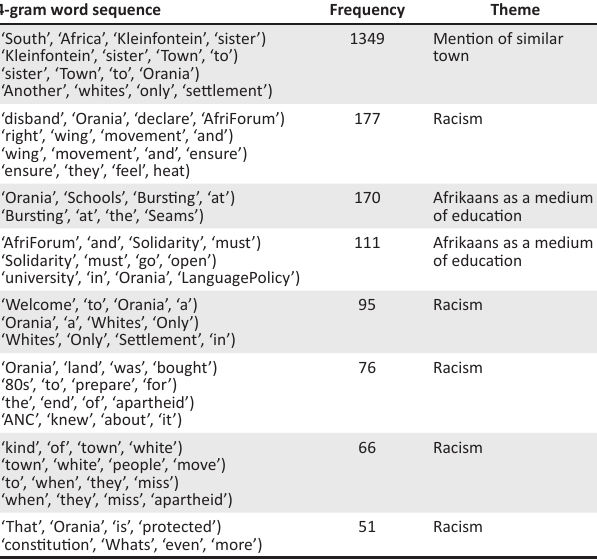
TABLE 2: n-gram word sequences and